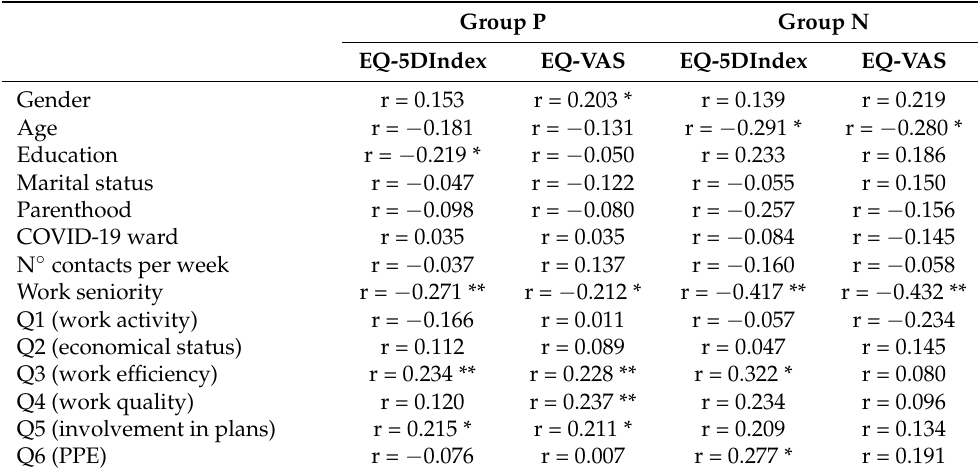
Table 4. Correlation matrix between European Quality of Life questionnaire and sociodemographic characteristics, work-related factors, and work environment perception in group P and group N.